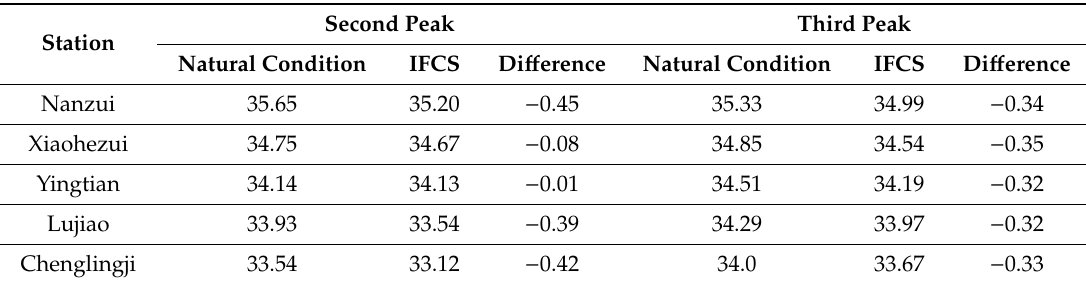
Table 4. The difference between the peak water level before and after using IFCS at selected hydrology stations (unit: m).